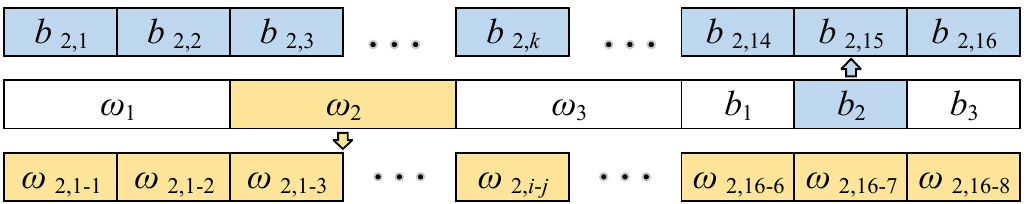
( b ) Distribution of normalized data Figure 4. Comparison of histograms before and after the data normalization.